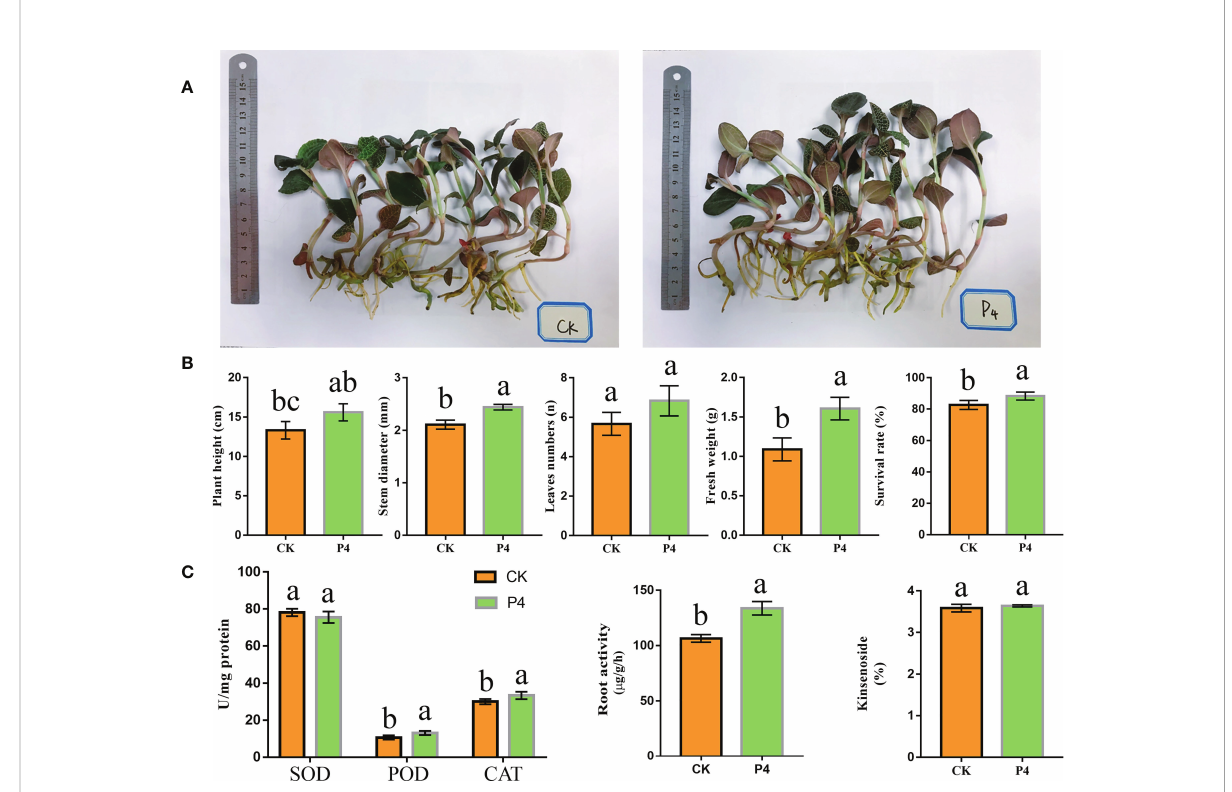
FIGURE 1 The growth traits of A. roxburghii . (A) Photograph of above- and belowground of A. roxburghii under different treatments. (B) The morphological traits of A. roxburghii . (C) Enzyme activity (including SOD, POD, and CAT), root activity, and kinsenoside of A. roxburghii . Different letters in columns indicate signi fi cant difference determined by Tukey ’ s test ( p < 0.05; n =